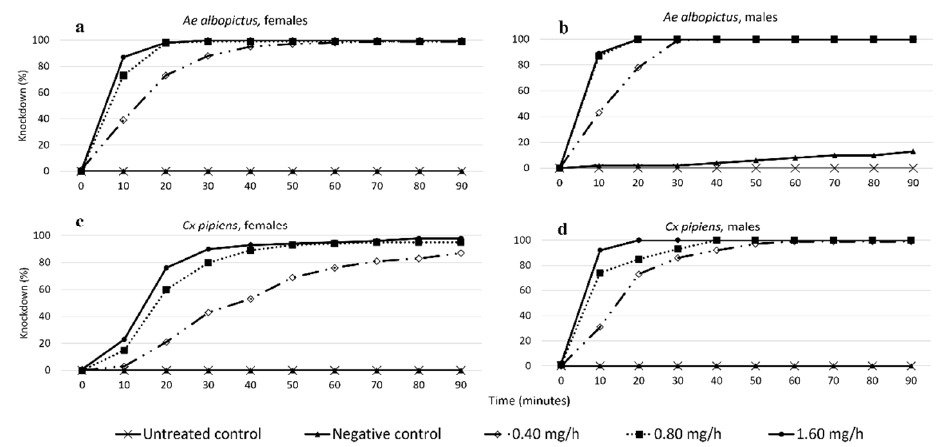
Figure 2. Knockdown over the 90-min treatment trial in Experiment 1 for female and male Ae. albopictus and Cx. pipiens across the five treatment groups: ( a ) Female Ae. albopictus , ( b ) male Ae. albopictus , ( c ) female Cx. pipiens ; and ( d ) male Cx. pipiens .